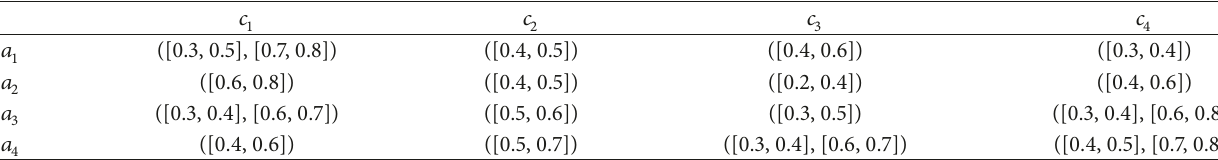
Table 4: The interval-valued hesitant fuzzy matrix 𝐻 1